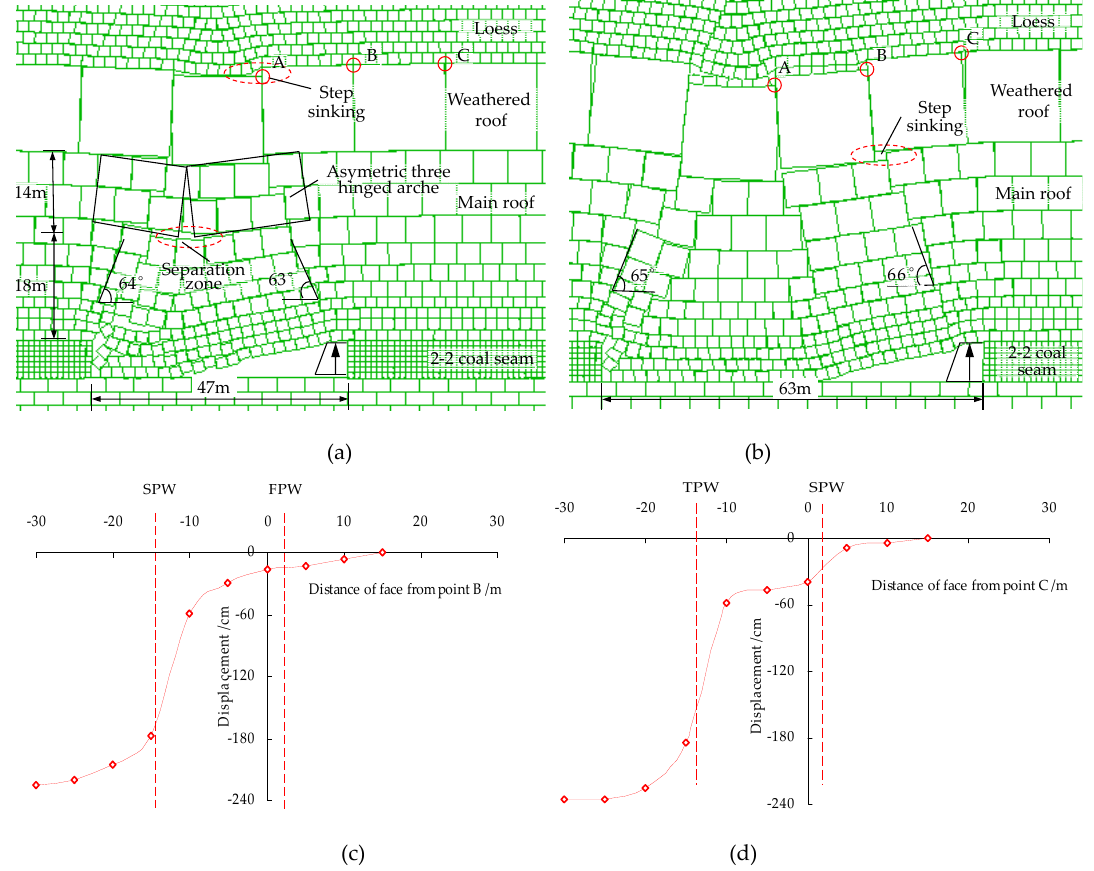
Figure 31. Movement and displacement of overburden during periodic weighting: (a) FPW; (b) SPW; (c) the displacement of point B; (d) the displacement of point C.